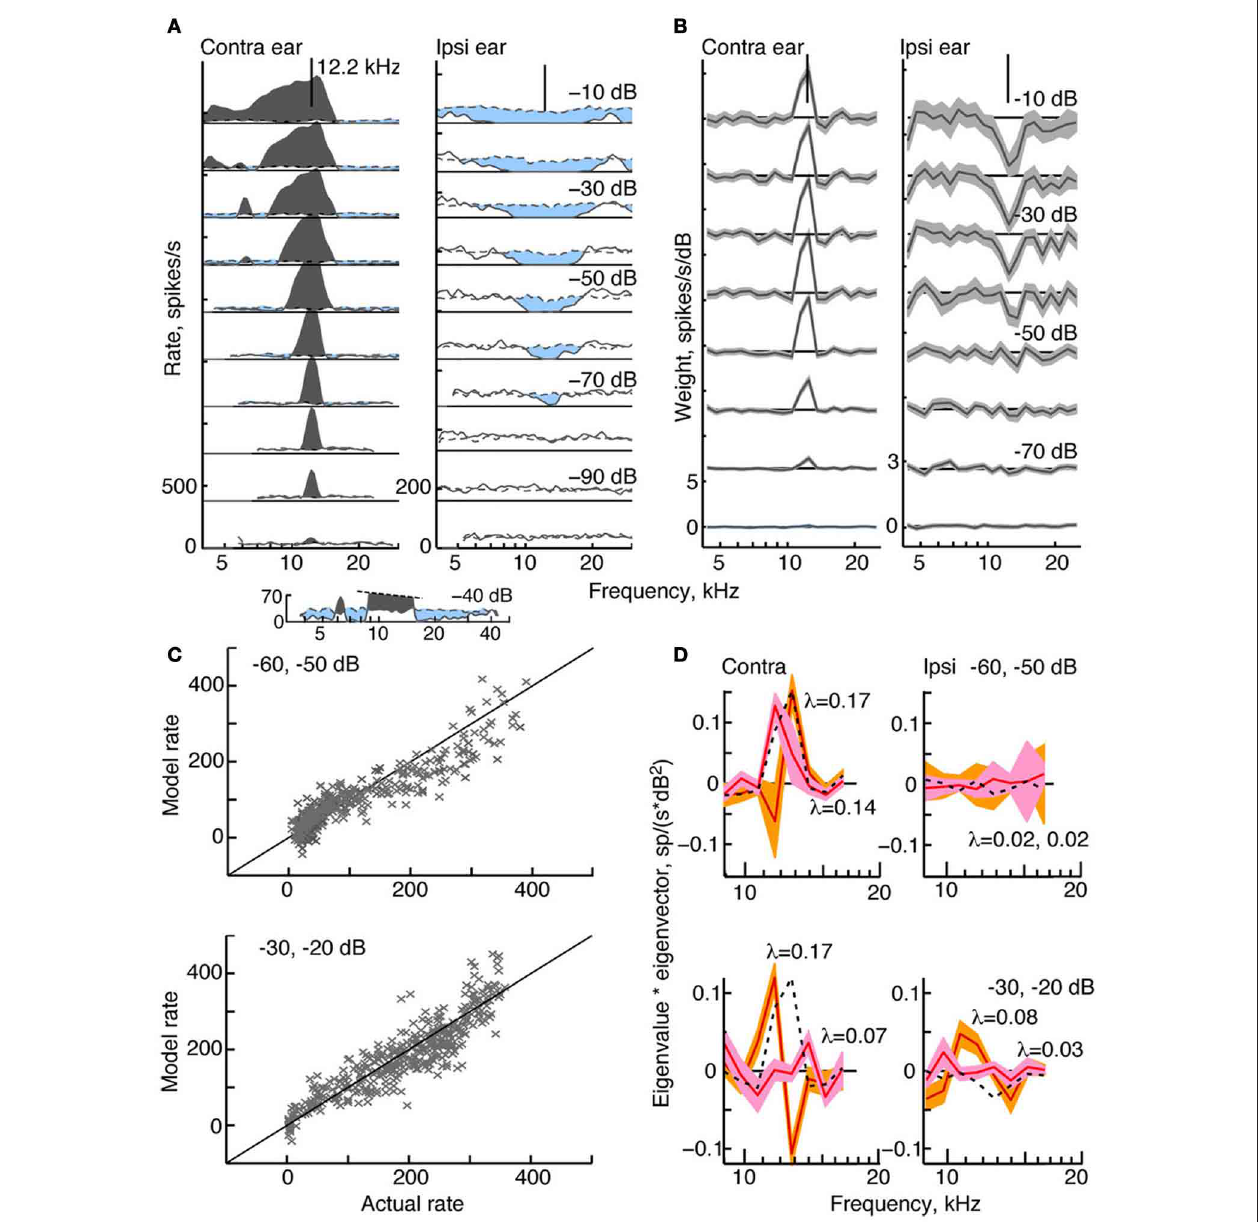
in (A) . Weight estimates are shown as black lines, and gray regions indicate ± 1 SEM. Contralateral and ipsilateral weight functions were derived from the same 200 responses to the binaural stimulus set. Note that the weight scales on the ordinate differ. (C) Rates predicted by the model (ordinate) vs. experimental rates (abscissa) in leave-one-out model testing. For each plot, data for two attenuations (indicated in the legend) were combined for the leave-one-out procedure. (D) Second-order effective filters (i. e., eigenvectors of M C and M I in Equation 3) for the same two fits shown in (C) . Eigenvectors multiplied by their corresponding eigenvalue are plotted against frequency. The 1st-order weights, scaled to the same maximum value in each plot, are shown as black dotted lines. Only eigenvectors with the two largest positive eigenvalues λ are shown (largest λ , orange; second-largest λ , pink). The colored regions indicate ± 1 SEM. The negative eigenvalues are smaller than the positive eigenvalues ( < 0.03, top case; < 0.1, bottom case) and the corresponding eigenvectors are noisy (not